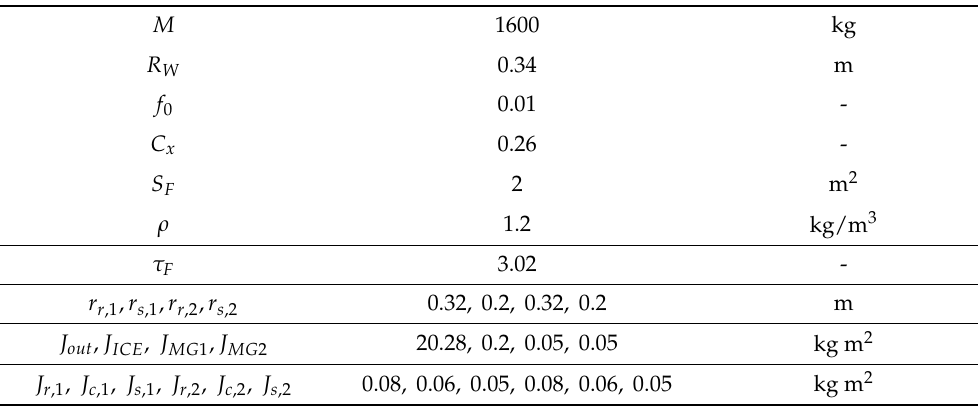
Table 1. List of vehicle parameters used for the η PW